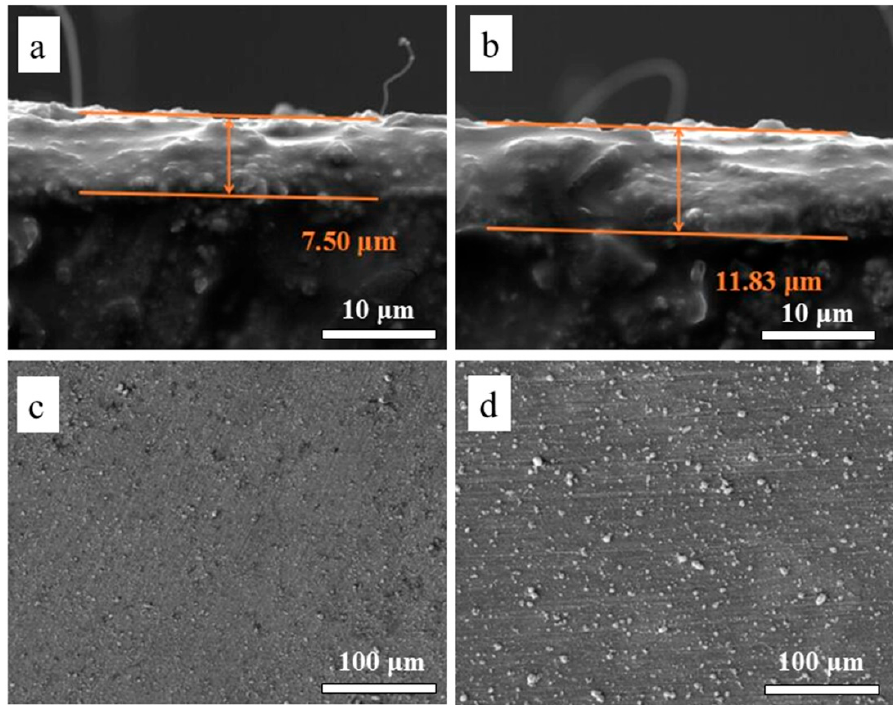
Figure 11. HA coating thickness ( a ) 1 mg/mL solution ( b ) 5 mg/mL solution, and surface morphology ( c ) 1 mg/mL solution ( d ) 5 mg/mL solution.